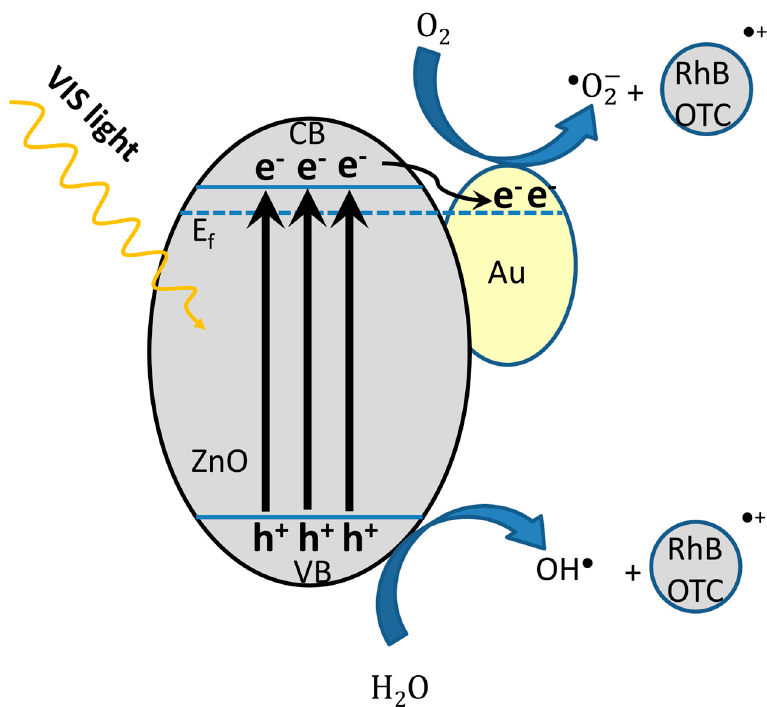
Figure 16. Schematic illustration of the photocatalytic mechanism depending on the behavior of the charge carriers.